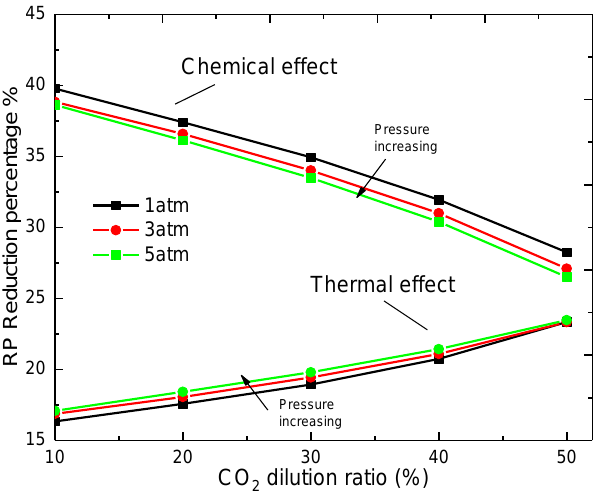
Figure 7. The comparison of 𝑅𝑃 𝑐ℎ𝑒𝑚 and 𝑅𝑃 𝑡ℎ𝑒𝑟𝑚 with different pressures at 𝛼 𝑠 = 10 s −1 , β = 0– 50%.